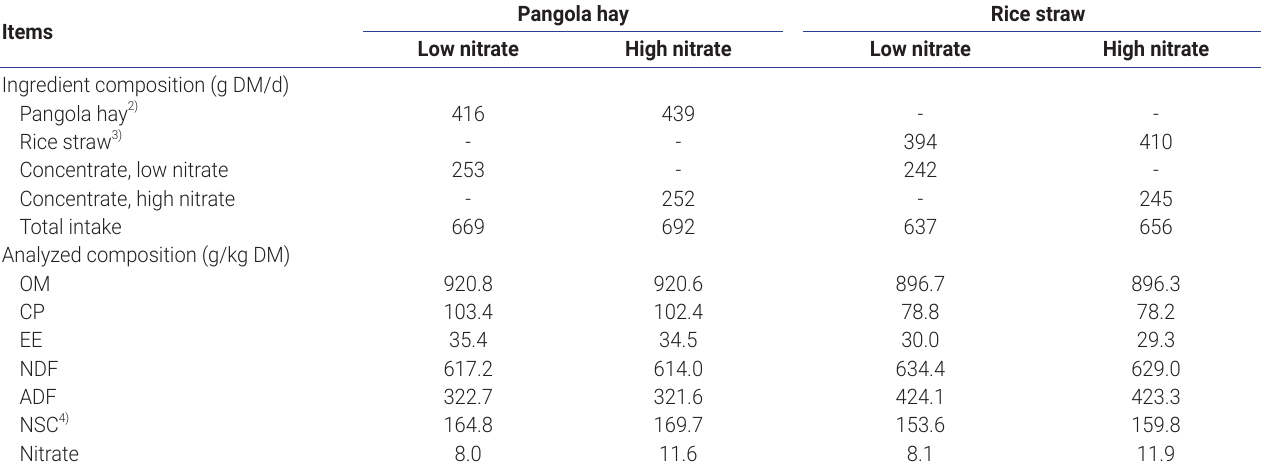
Table 2. The ingredient and chemical composition of the experimental rations 1)